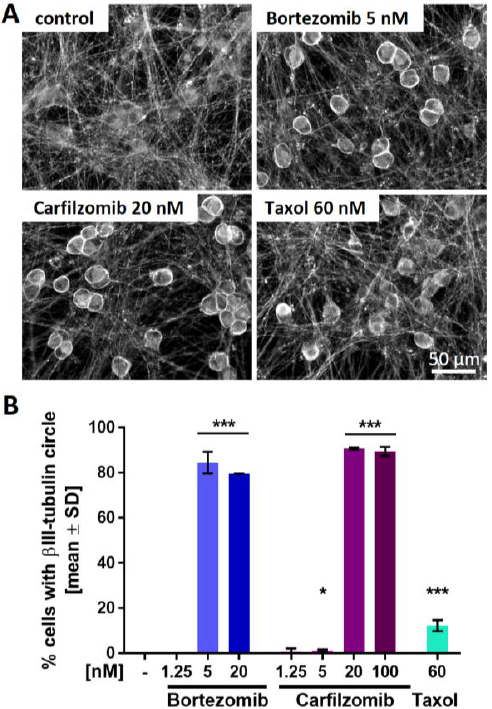
Figure 6. Proteasome inhibitor-induced reorganization of the microtubule structure in neuronal somata. Sensory neurons were differentiated for at least 38 days after thawing and exposed to bortezomib, carfilzomib, or taxol for 24 h before fixation. ( A ) Representative immunofluorescence images of cells stained for β III-tubulin. A scale bar is given in the images, and further details are shown in Figure S11. ( B ) Cells exhibiting intense, circular β III-tubulin staining around the cell somata (covering at least 50% of a full circle) were quantified. Data are given as % of the total cell count (number of viable cell nuclei) and are expressed as the mean ± SD of 2–3 biological replicates. *, p < 0.05; ***, p <